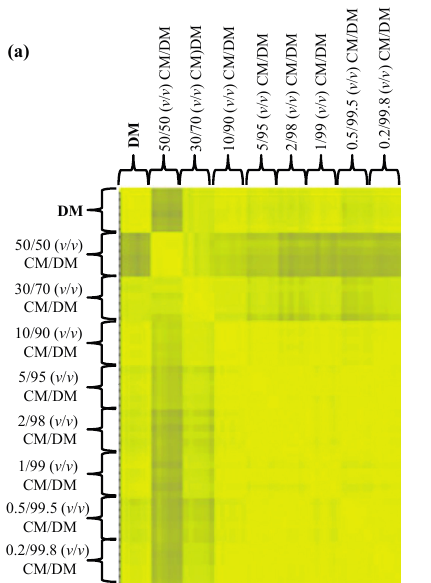
Figure 5. Pearson’s correlation matrices of all spectral replicates for the eight mixtures (from 50% to 0.2%) of simulated adulterations of ( a ) DM with CM and ( b ) GM with CM. Correlation coefficients are represented with decreasing blue and yellow colors according to a scale ranging from 0 to 1,